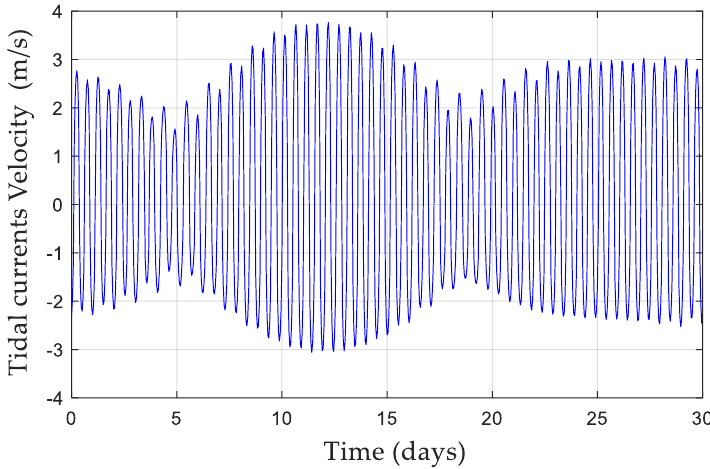
Figure 7. Tidal current velocity in Raz de Sein tidal site (after reproduction from [38]).